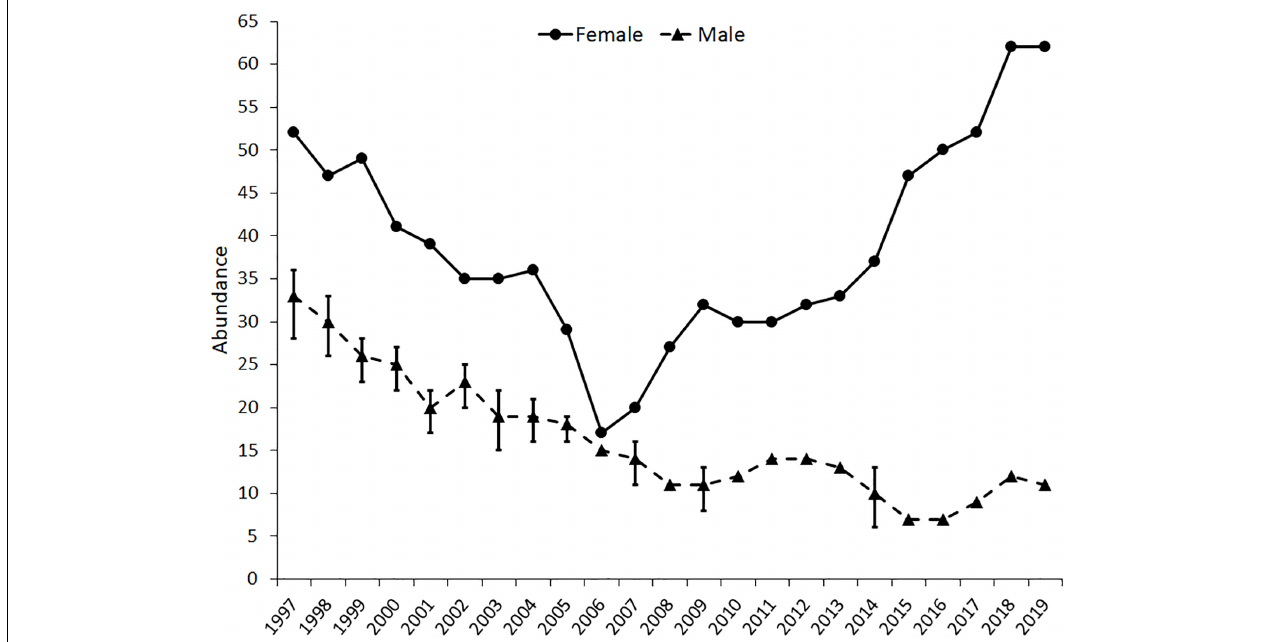
FIGURE 1 | Time series of abundances of the Davison herd (female) and male population. Error bars are 95 percent confidence intervals for years when male abundances were estimated using Bowden’s mark-resight estimator.